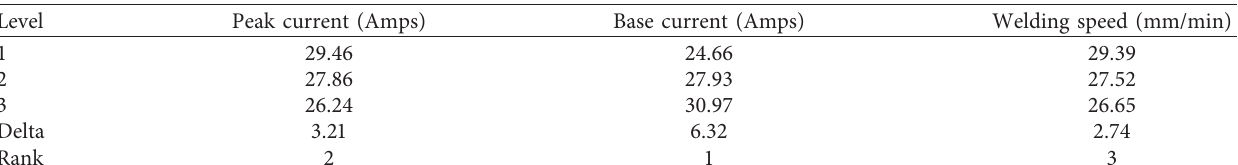
Table 12: Response table for S/N ratios (impact strength) (larger is better).